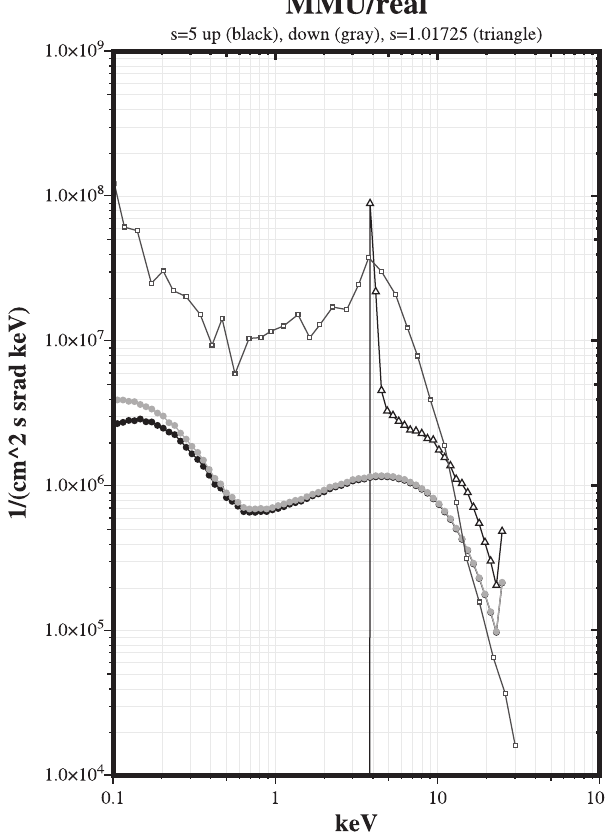
Fig. 13. MMU/real: source plasma corresponding to the dashed line in Fig. 7 accelerated through a U-shaped potential. The line marked with squares is the FAST data (the same as the dotted line in Fig. 7). The potential drop is selected to match FAST peak position (3.8 kV). The peak is much too narrow and its shape